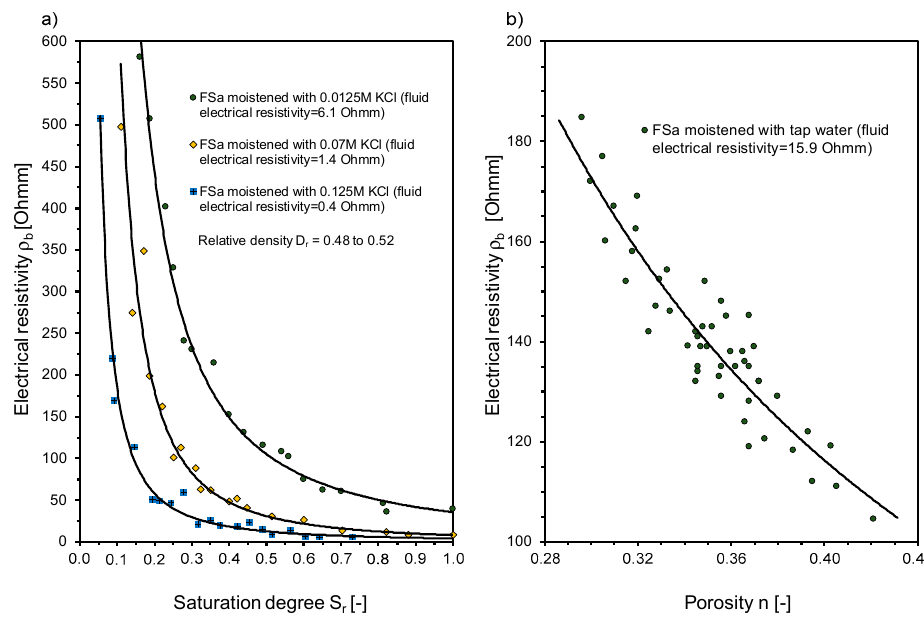
Figure 7. Analytical relation between electrical resistivity of fine sand (FSa) moistened with different KCl solution vs. saturation degree ( a ) and electrical resistivity vs. porosity ( b ).